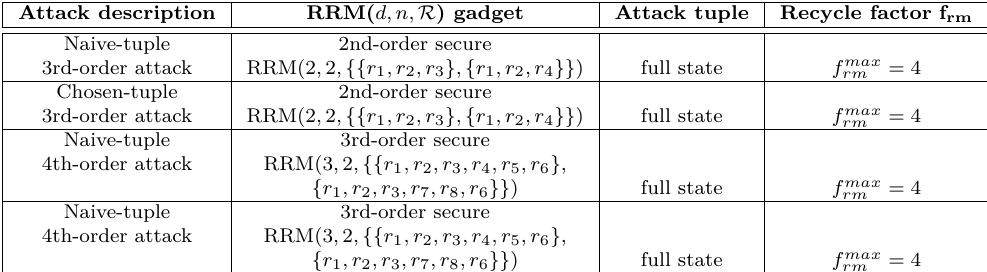
Table 4: t − NI RRM gadgets analyzed using a conservative bound assuming naive-tuple (C1) and full-state (C3)